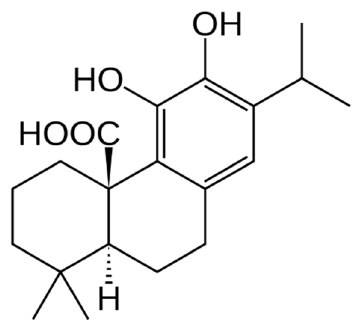
Figure 1. Structure of carnosic acid.